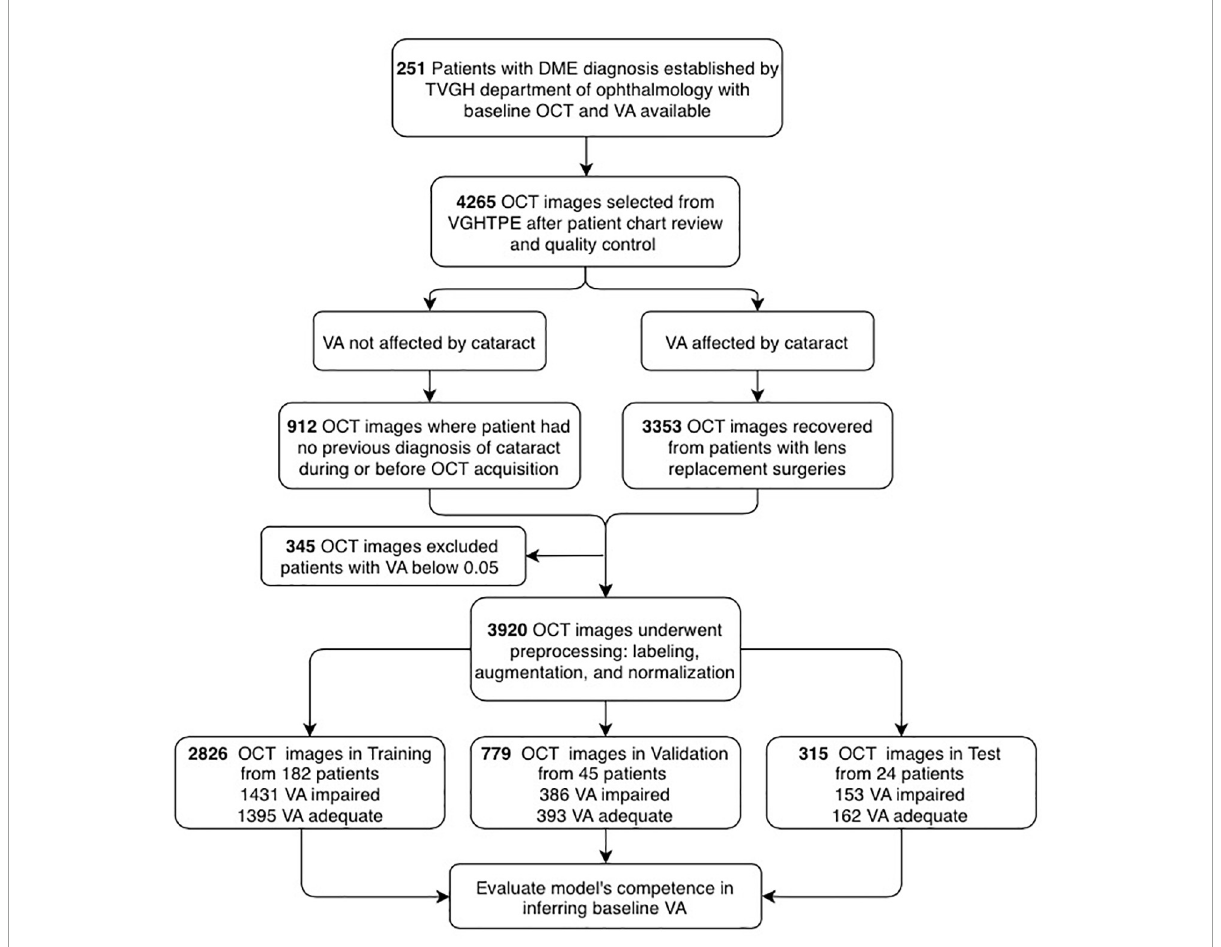
FIGURE3 Flowchart showing the selection of optical coherence tomography (OCT) images and their analysis. OCT images and patient clinical information were de-identified secondary data released for retrospective research purposes ( N = 4,265). The OCT images were collected from the patients diagnosed with DME with clear lens ( N = 912) or artificial intraocular lens ( N = 3,353), best-corrected visual acuity (BCVA) measured from 0.05 to 1.5 (decimal), excluding those with lower than 0.05 ( N = 3,920). Afterimage preprocessing, the dataset was categorized into training ( N = 2,926), validation ( N = 779), and test ( N = 315) for the establishment of the AI platform.